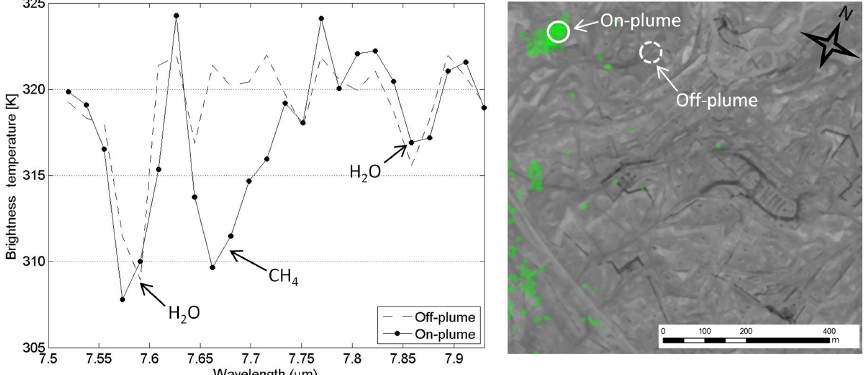
Figure 8. HyTES brightness temperature spectra (left) from 7.5 to 8µm for an on-plume and off-plume pixel indicated in the CMF tempera- ture overlay (right) for a plume over the Kern River oil field in July 2014. The presence of H 2 O features in both the on-plume and off-plume pixels but only CH 4 in the on-plume pixel indicates the latter detection is not a false positive.